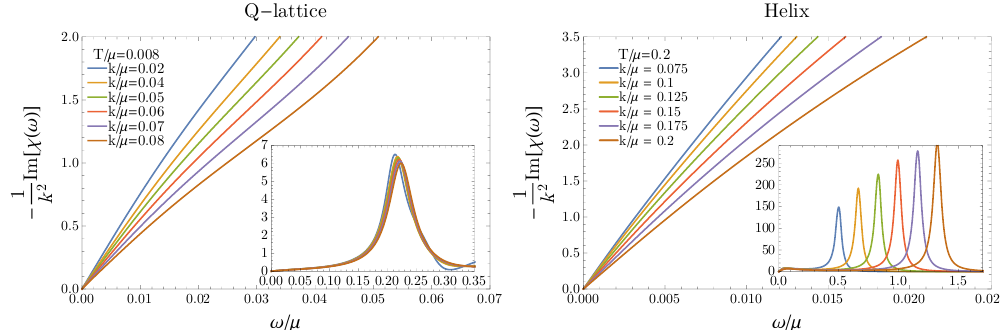
Figure 6. Charge density response function. The Coulomb interaction is taken into account with e 2 = 0 : 05 (both models). The remaining parameters are the same as on (cid:12)gure 5. The di(cid:11)usion peak near the origin totally disappears in both models. The only remaining visible feature (the insets on both panels) is the broad slowly dispersing peak, which is located at parametrically large frequencies: the fake plasmon. At low energies, the response looks